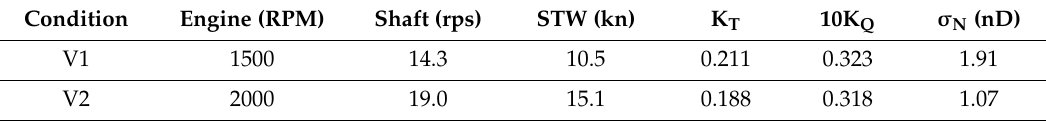
Table 2. Full-scale operational conditions during sea